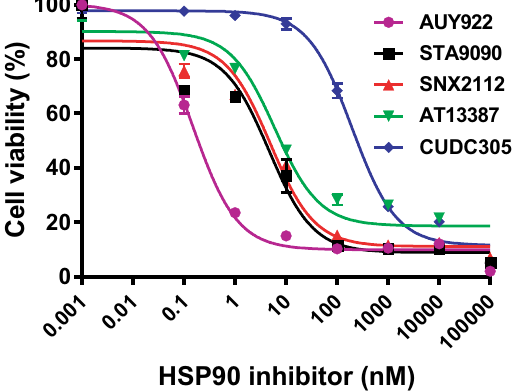
Figure 1. Heat shock protein 90 (HSP90) inhibitors suppress cell growth and proliferation in human bladder carcinoma cells. 5637 cells were evenly distributed in 96-well plates (5 × 10 3 cells/well) and treated for 72 h with AUY922, ganetespib (STA9090), SNX2112, AT13387, or CUDC395 at the indicated concentrations. The ability of HSP90 inhibitors to inhibit cell growth and proliferation was determined by the MTS assay, as described in the “Methods”. Cell viability values are expressed relative to those for cells with no HSP90 inhibitor exposure (control value, 100%). The results represent the means ± SD of three independent experiments.